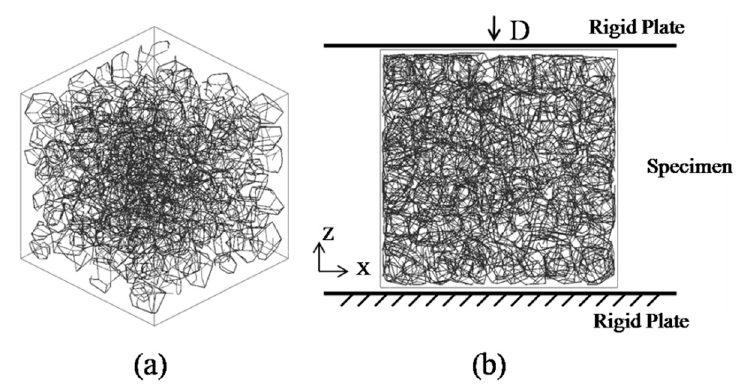
Figure 13. Meshing results for concrete specimen: ( a ) Two crossing planes cut view, ( b ) local enlargement cut view.